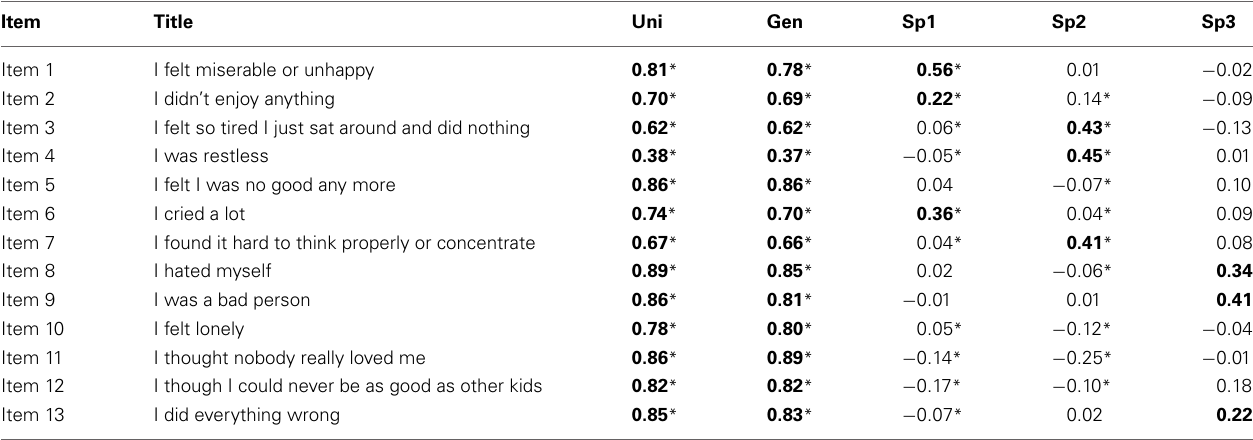
Table 1 | The factor structure of the Norwegian translation of SMFQ: